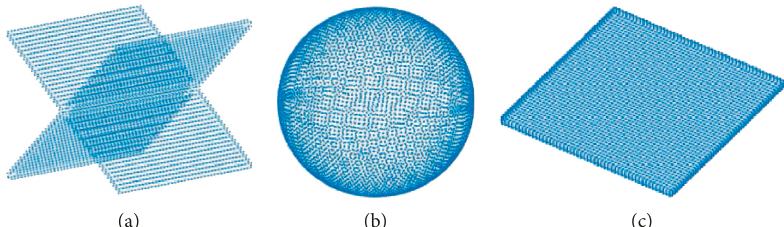
Figure 4: Discrete model diagram of three different geometric shape markers: (a) cross board, (b) sphere, and (c) square